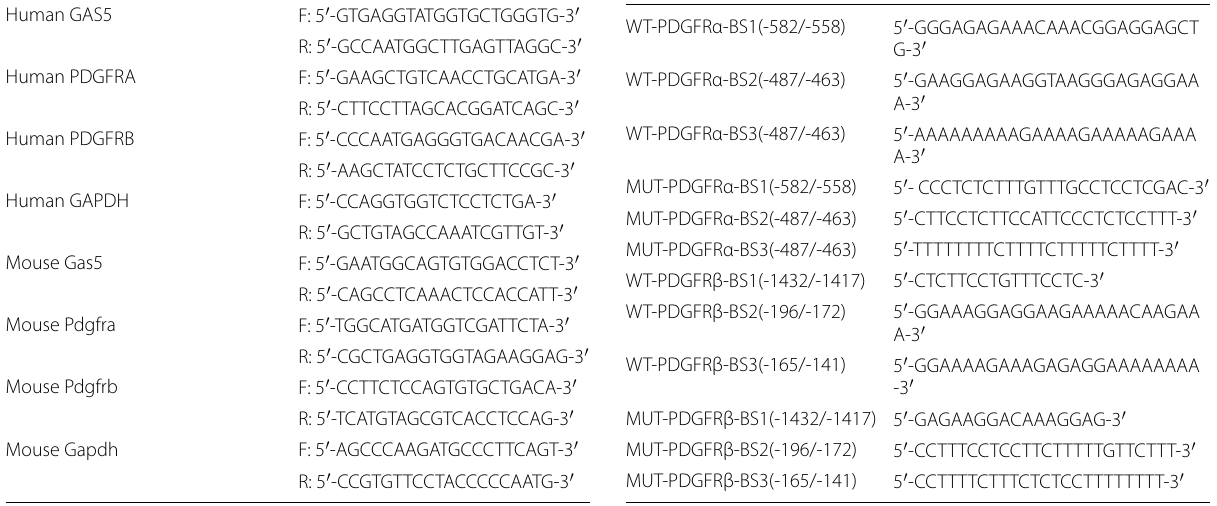
Table 4 Sequences for PDGFRα/β promoter containing the wild type (MT) or mutant (MUT) binding sites in